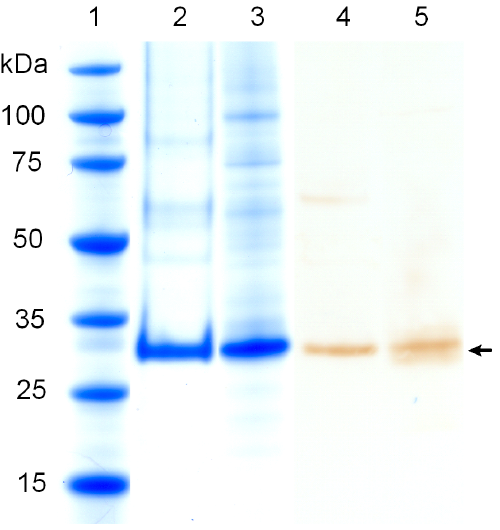
Figure 3. Purification of NTS1. The progress of purification was monitored by SDS-PAGE (NuPAGE 4–12% Bis-Tris gel, Invitrogen, 1 6 MES SDS buffer) and SimplyBlue staining. The arrow indicate the NTS1 band. Lane 1: Novagen Perfect Protein Marker (15–150 kDa); lane 2: Talon eluate of NTS1 produced in T-REx-293 cells (3.5 m g); lane 3: Talon eluate of NTS1 produced in insect cells (6 m g); Western blot analysis of total cell extract was performed using the HisProbe-HRP reagent recognizing the histidine tag. Lane 4: NTS1 produced in T-REx-293 cells (122,000 lyzed cells with 113 ng functional NTS1); lane 5: NTS1 produced in insect cells (110,500 lyzed cells with 107 ng functional NTS1).